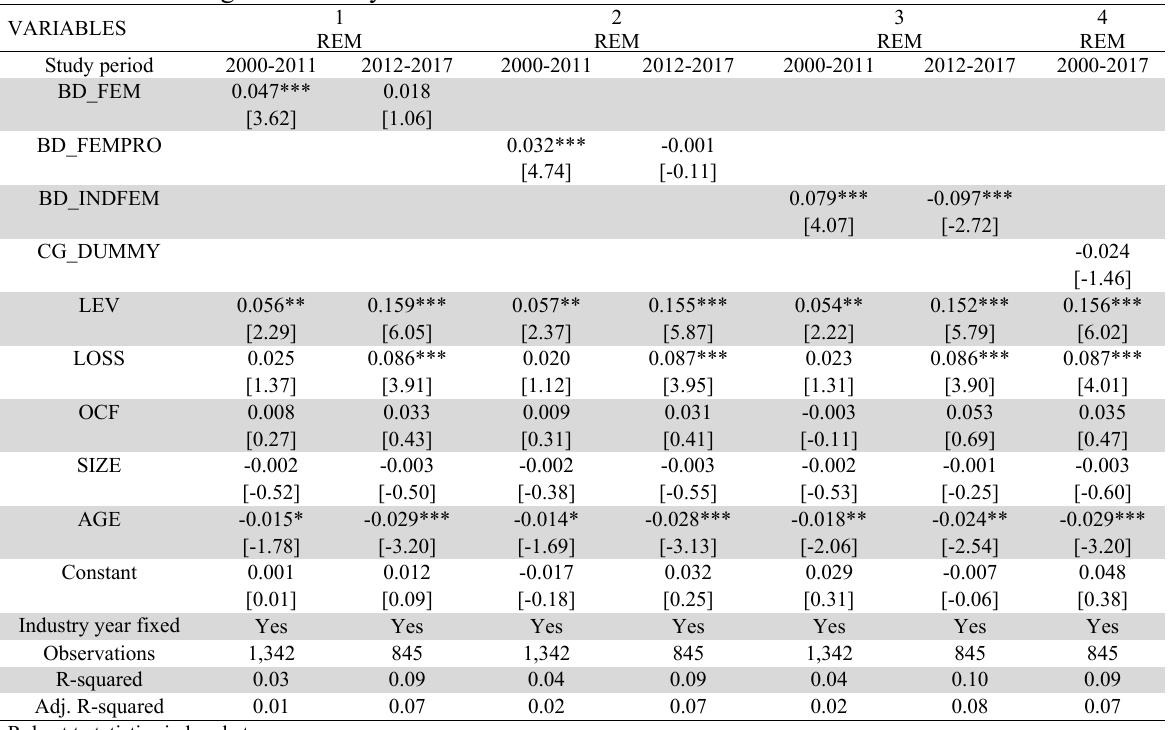
The results of the regression